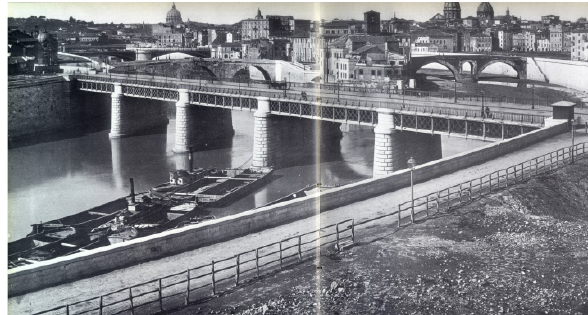
Figure 8. Palatino Bridge and the view of the city (Jodice,